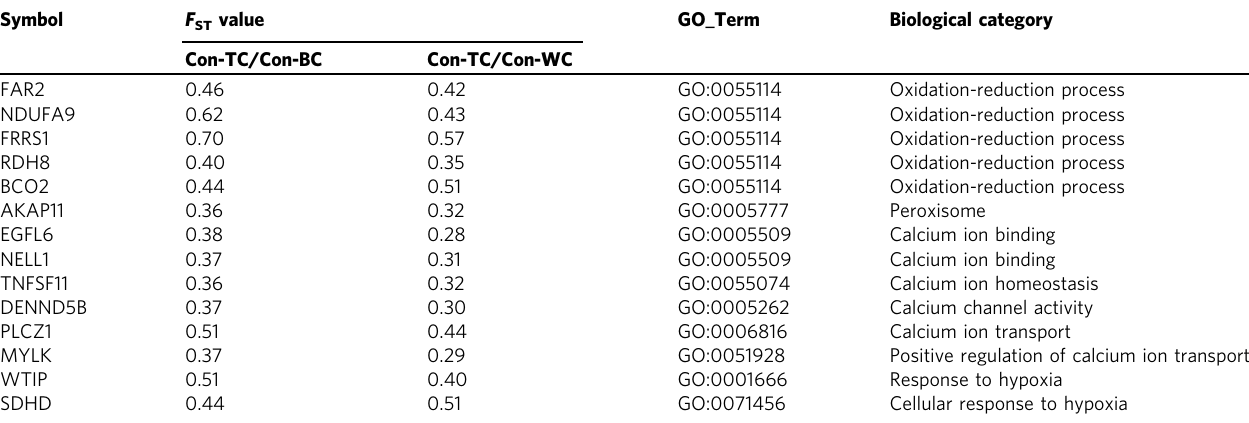
Table 1 Summary of candidate genes that may have a role in the high-altitude adaptation of TC. Symbol F ST